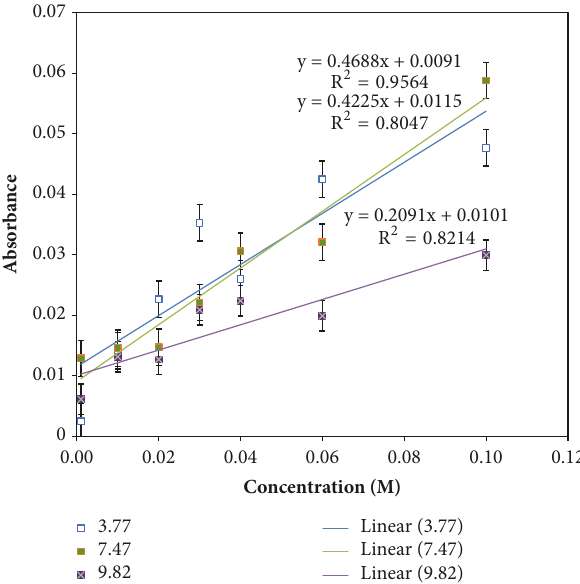
Figure 4: Calibration curves for hydroxylamine nitrate using the QCL-ATR system. The response was very similar for the peaks at 3.77 and 7.46 𝜇 m, with the latter giving better linearity. The sensitivity at 9.81 𝜇 m was half that seen at the shorter wavelengths.